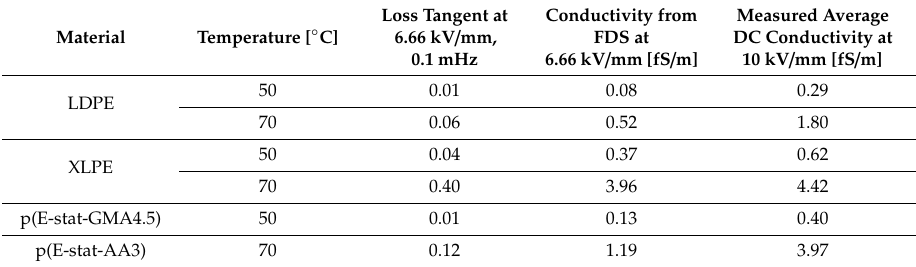
Table 1. Conductivity estimated from dielectric response